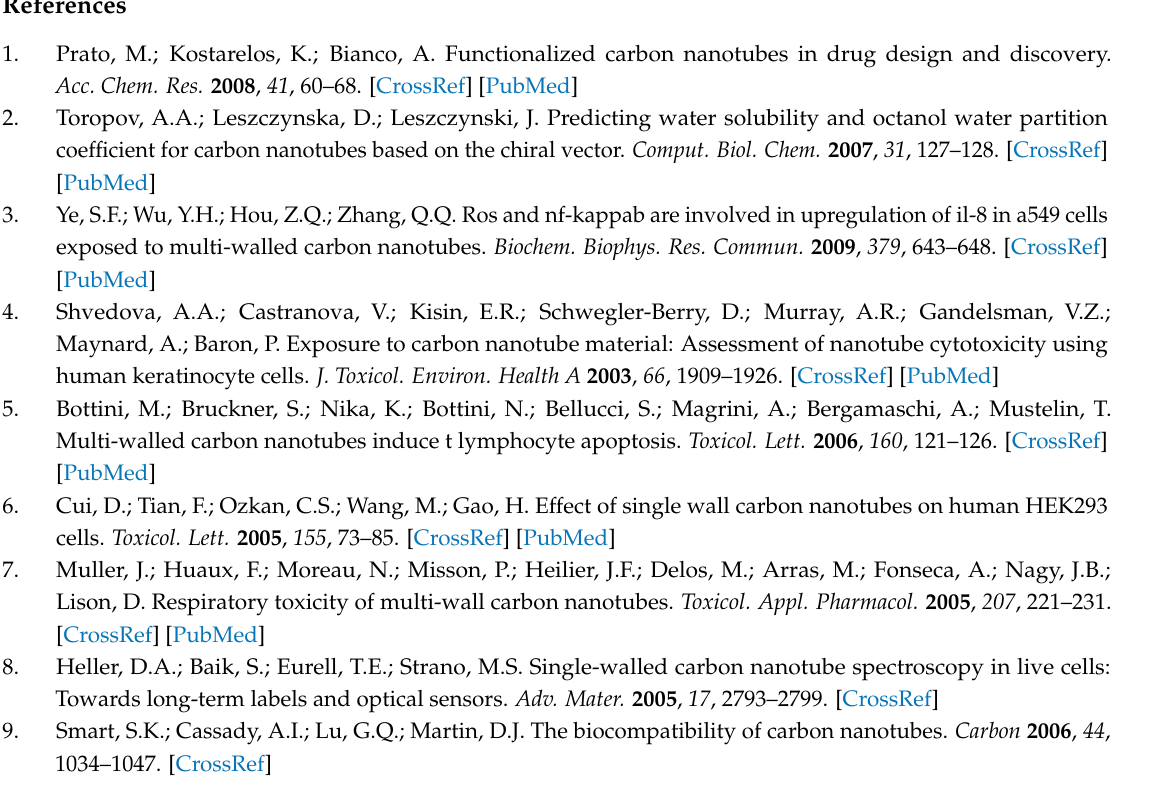
Table S1. Properties of CNT families, Figure S1. Raman spectra for carbon nanotubes used in the present study, Figure S2. Control profile of mitochondrial oxygen mass flux of isolated rat liver mitochondria (Y2: Red